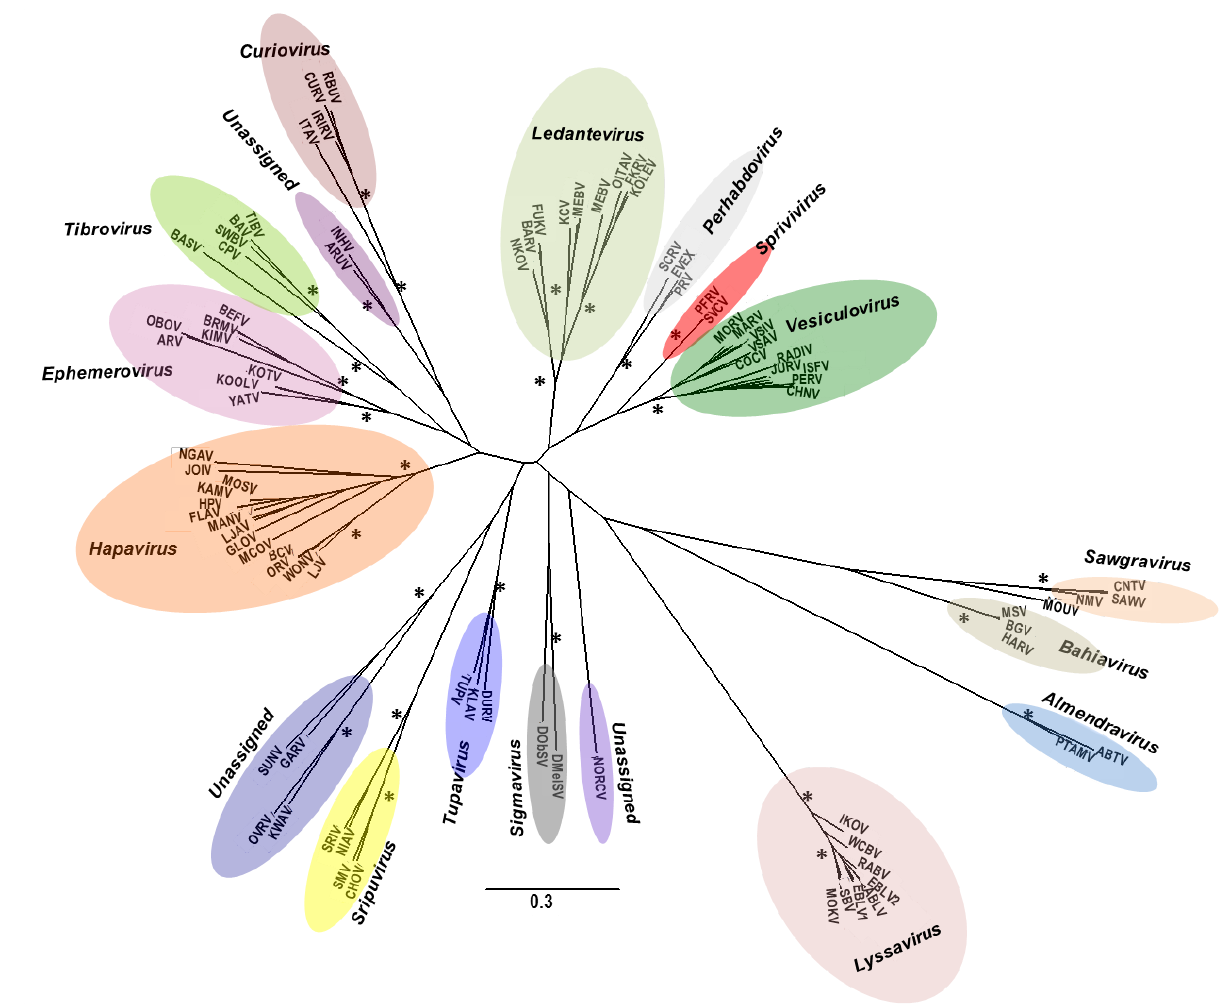
Figure 3. Rhabdovirus: Maximum-likelihood (ML) analysis of rhabdovirus L protein sequences. Horizontal branch lengths are drawn to a scale of amino acid substitutions/site, and all bootstrap support values ≥85% are indicated by an asterisk. Cytorhabdovirus, novirhabdovirus and nucleorhabdovirus outgroup sequences were excluded from the tree as they were too divergent to establish a reliable rooting. The tree is therefore rooted arbitrarily on one of two basal clades (genera Almendravirus and Bahiavirus) that comprise viruses isolated from mosquitoes. Branch labels indicate virus abbreviation. Additional virus isolate information is contained in a supplemental file. (Adapted from [73]).